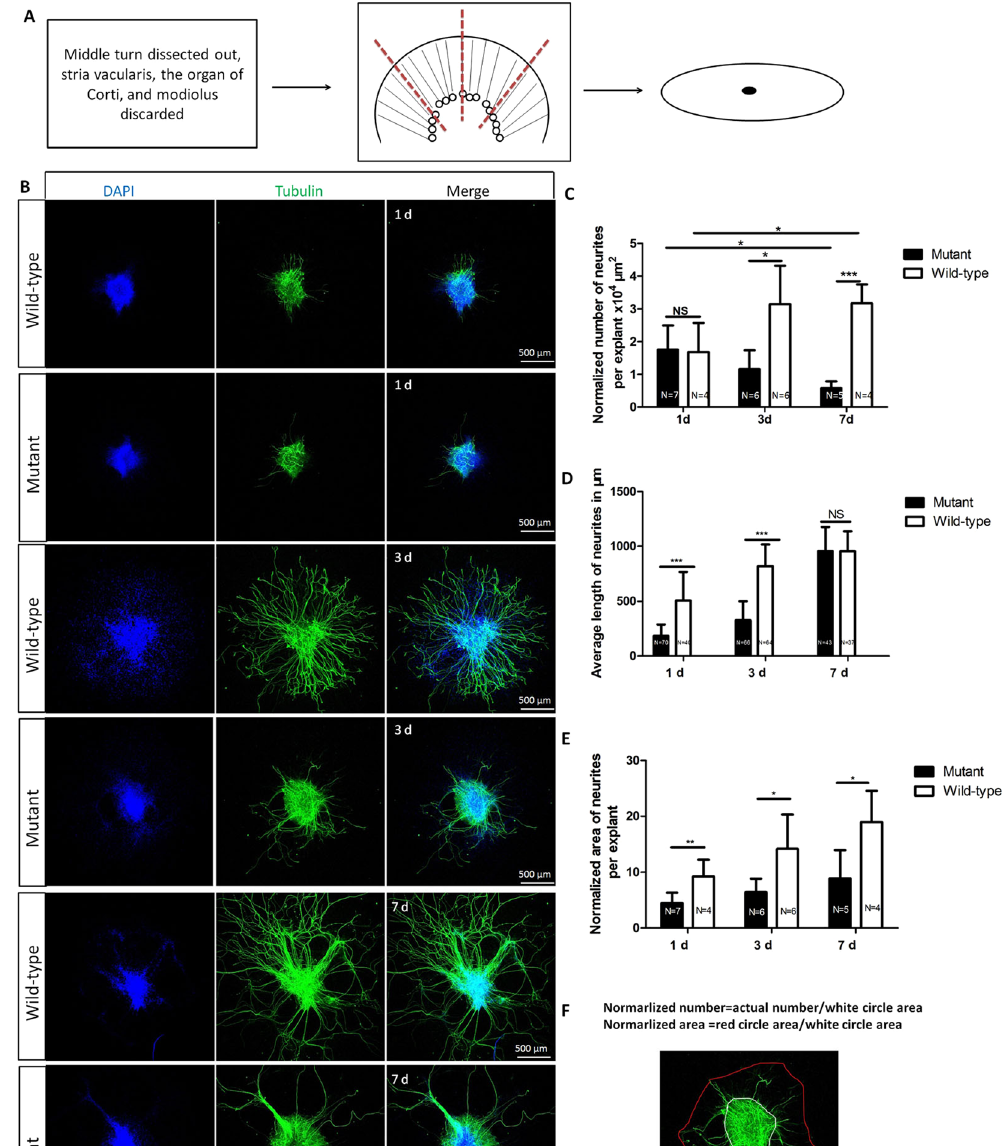
Figure 5. Lack of SPAG6 affects the growth of SGNs in vitro The schematic of dissection and culture of SGN explants form neonatal mouse cochleae. The middle turn of P3 cochlea was dissected out, the strial vacularis, the organ of Corti, and the modiolus were discarded, and remnant SGN bulk was cut into four equal pieces, attached to coverslips, and cultured. ( B ) Neurite regrowth from Spag6 wild-type and mutant mice in SGNs explants in 3D culture for 1–7 days. ( C ) The normalized number of the regenerating neurites were compared between the mutant and wild-type mouse SGN explants. At1 d, the mutant SGN explants showed no obvious difference in normalized regenerating neurite number compared with wild-type SGNs (mutant, 1.7560 ± 0.7404, N = 7; wild-type, 1.6855 ± 0.8923, N = 4, P > 0.05). Nevertheless, at 3 d (mutant, 1.1576 ± 0.5817, N = 6; wild-type, 3.1477 ± 1.1703, N = 6, P < 0.05) and 7 d (mutant, 0.5802 ± 0.2070, N = 5; wild-type, 3.1759 ± 0.5734, N = 4, P < 0.001) the mutant SGN neurite number decreased compared to the wild-type explants. Furthermore, in the wild-type SGNs explants, the normalized neurite number at 7 d was significantly higher than that at 1 d (P < 0.05). However, in the Spag6 mutant SGN explants, the normalized neurite number at 7 d was significantly less than that at 1 d (P < 0.05). ( D ). The length of regrowth neurites was measured. At 1 d and 3 d, the SGN expants from mutant mice showed shorter neurites than the control group (P < 0.001, P < 0.001). However, at 7 d, there was no significant difference in neurite length. E. The normalized total surface occupied by regenerating neurites was analyzed. The mean area at 1 d (mutant, 4.4587 ± 1.8765, n = 7;wild-type, 9.2646 ± 2.9597, n = 4, P < 0.01), 3 d (mutant, 6.4202 ± 2.4323, n = 6;wild- type, 14.1673 ± 6.1332, n = 6, P < 0.05)and 7 d (mutant, 8.9067 ± 5.0314, n = 5; wild-type, 18.9988 ± 5.5690, n = 4, P < 0.05) were different between mutant and wild-type SGNs. “n” indicates the SGN explant number. F. The white irregular shape means SGN explant area. The red irregular shape means the actual area occupied by neurites. The normalized number of neurites in C is a ratio of actual neurite number to white irregular